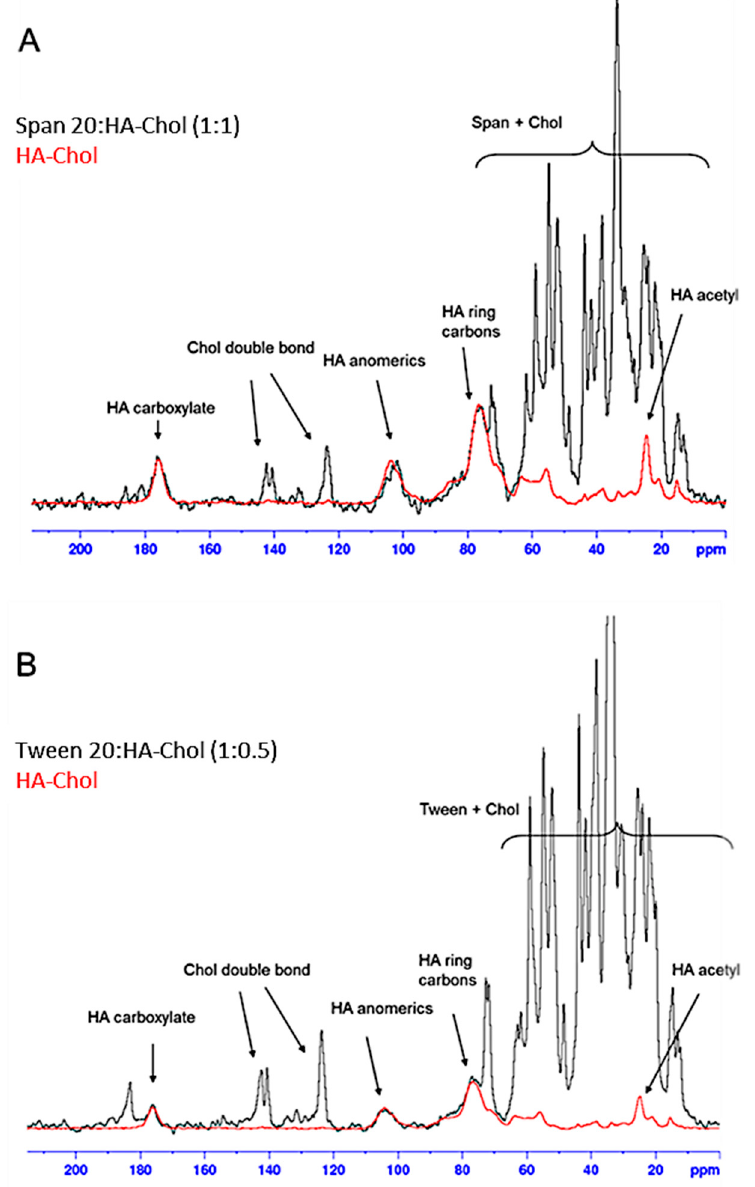
Figure 3. 13 C CP-MAS NMR spectra of the samples S2 1:1 ( A ) and T 1:0.5 ( B ) superimposed with the spectrum of HA-Chol polymer carried out at 200.63 MHz at 27 °C.